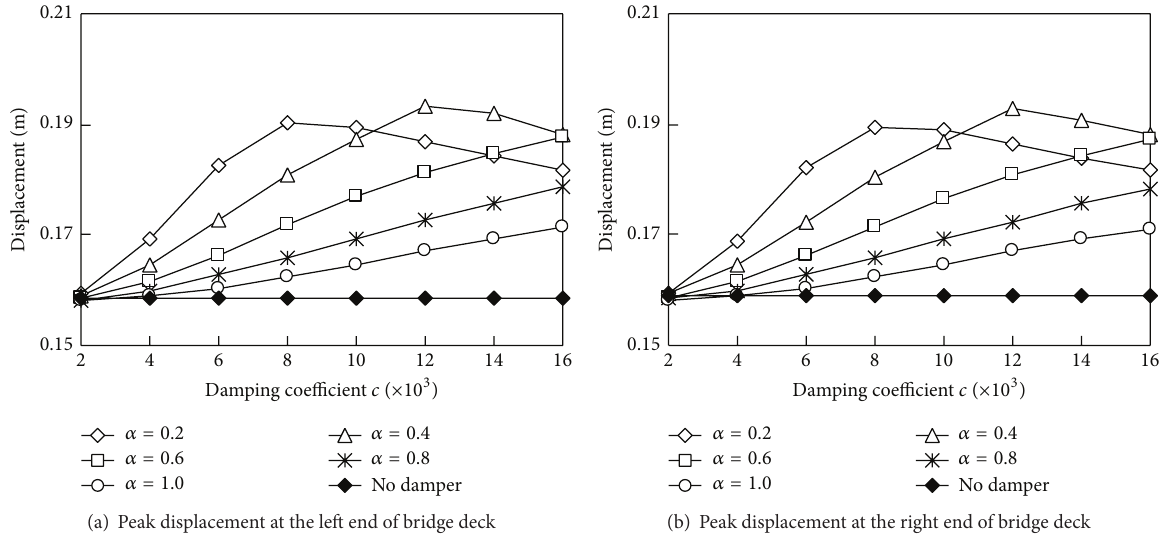
Figure 10: Effects of variations in damping coefficient and velocity exponent of the viscous fluid dampers on the peak displacements at two ends of bridge deck.